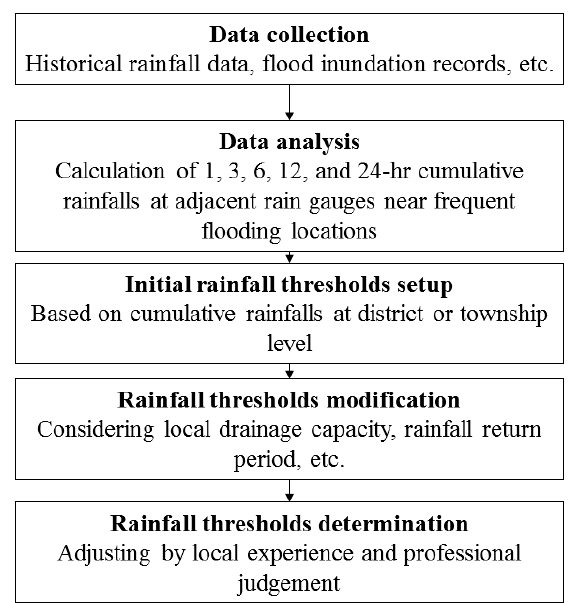
Figure 1. The procedures for determining Water Resource Agency rainfall thresholds (WRTs).